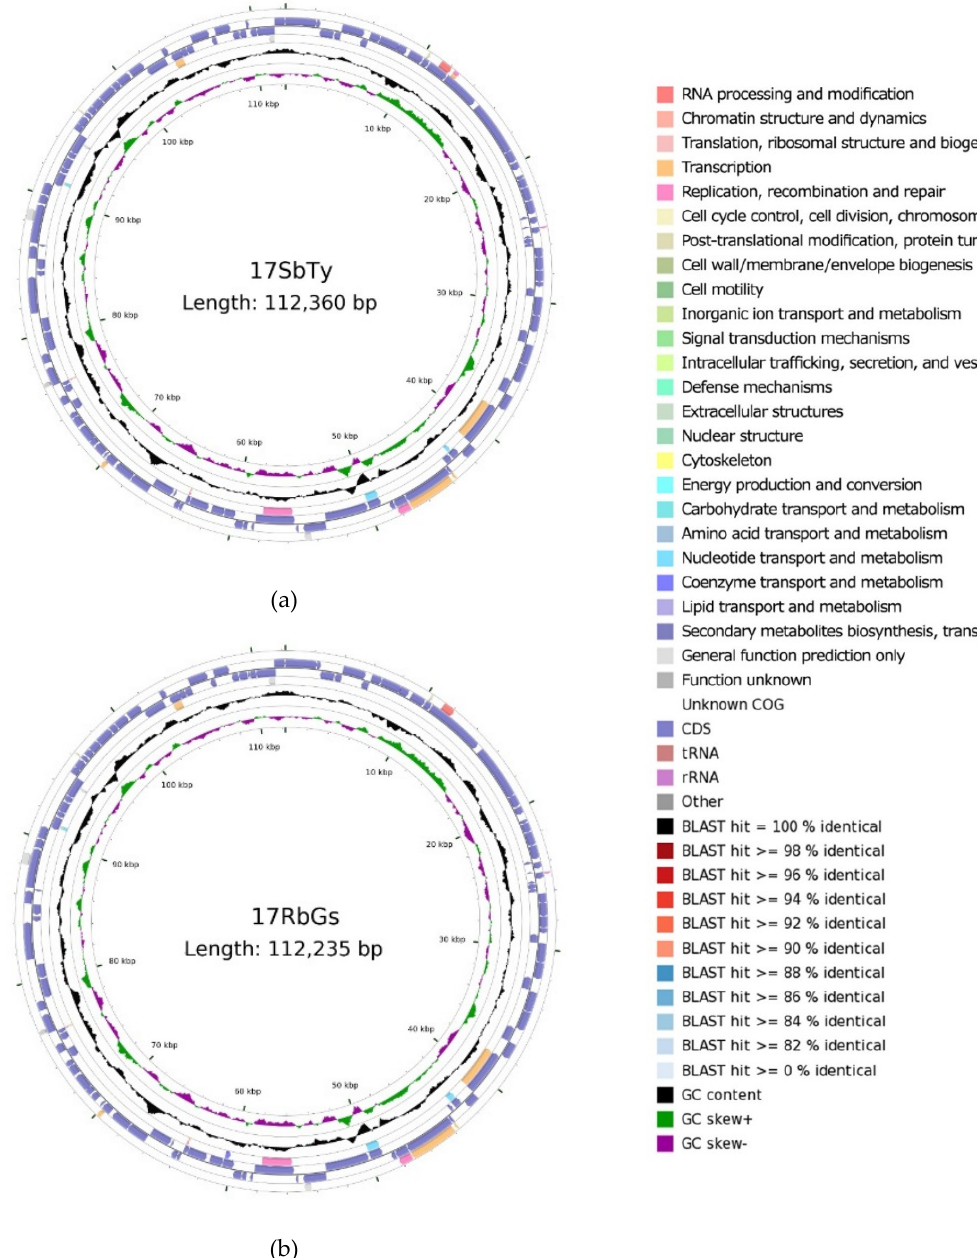
Figure 2. Circular genome maps of ( a ) 17SbTy (112,360 bp) and ( b ) 17RbGs (112,235 bp). From the inner ring to the outer ring, the first and eighth circles represented the genomic length (kbp) and nucleotide positions, respectively. The second and third circles show the G+C skew and G+C content, respectively. The fourth and fifth circles represent rRNA and tRNA genes on forward and reverse strands, respectively. The sixth and seventh circles indicate the functional categories of the protein-coding sequences in terms of clusters of orthologous groups (COG) on the forward and reverse strands, respec- tively.